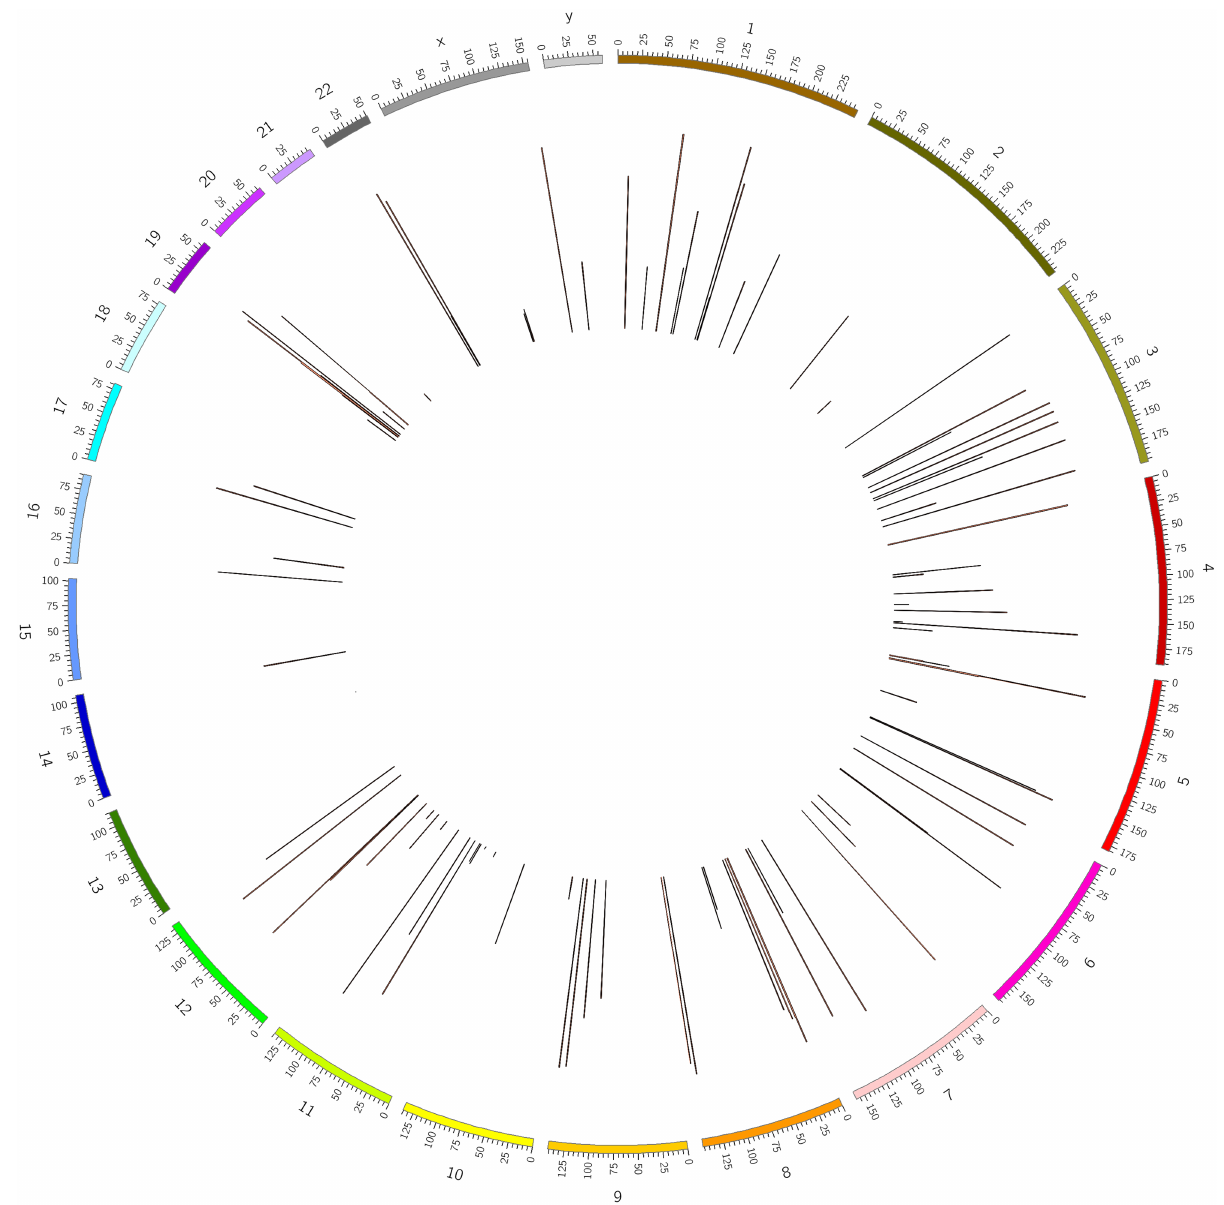
Fig 1. Exact locations of 104 new putative MAs of HERVs in the human chromosomes.